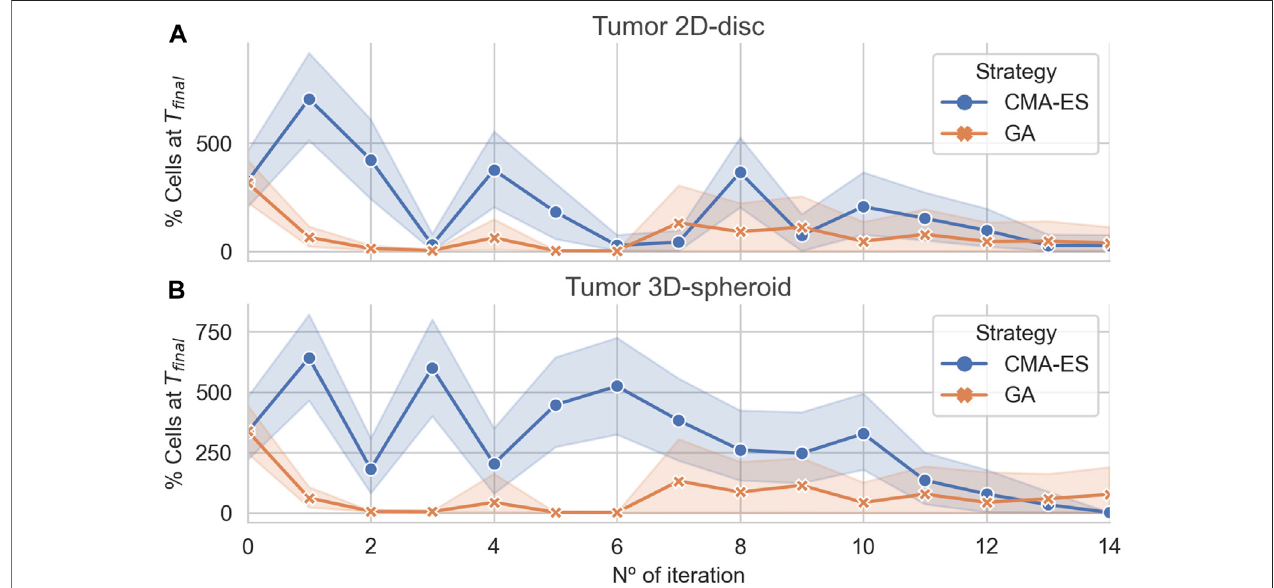
FIGURE4| Algorithmicconvergencefortheoptimizationoftreatmentparameters.Theaverage%ofalivecellsattheendofeach iterationstepoftheCMA-ESand GA optimization algorithms. Panels (A) and (B) show the convergence of the algorithms for simulations considering a population of cancer cells arranged in a 2D disc and a 3D spheroid,